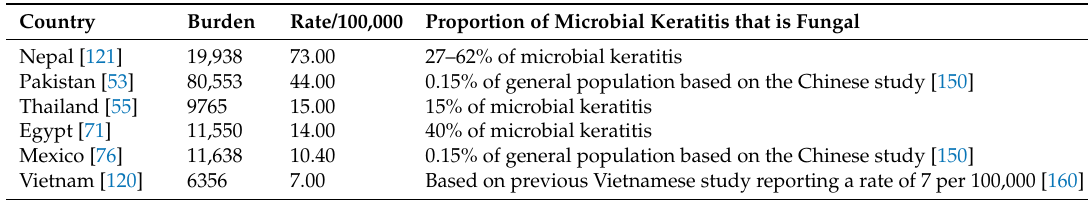
Table 8. Country estimates of the burden of fungal